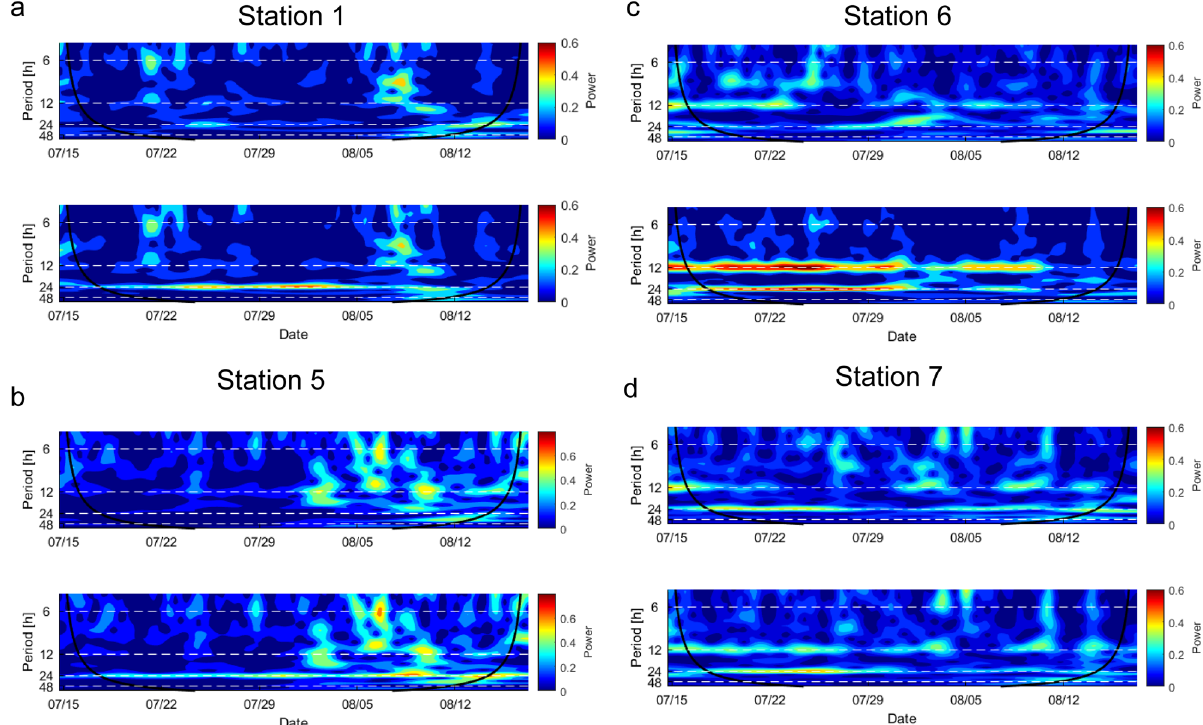
Figure 4. Wavelet power spectrum for the period from mid-July to mid-August at: ( a ) station 1, ( b ) station 5, ( c ) station 6, and ( d ) station 7. The lower spectrogram at each station shows the initial CO 2 flux, while the upper spectrogram shows the residual CO 2 flux. The time period shown here was chosen because of its continuous data coverage. Black solid lines represent the cone of influence, with areas outside the black line potentially affected by edge-effect artefacts. The wavelets were created with the MATLAB software, version